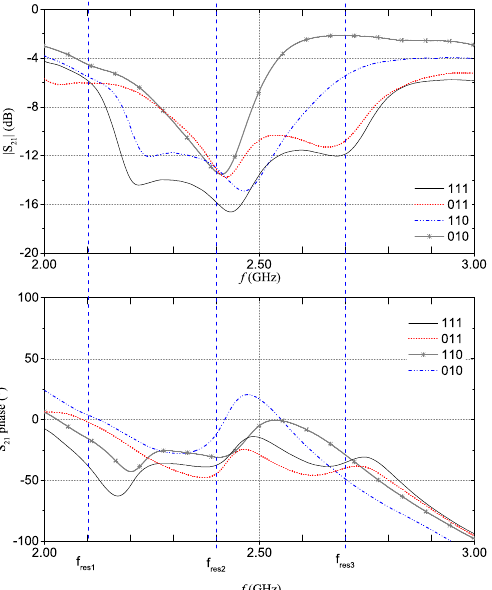
Figure 9. Measurement results for the multi-stopband structure: measurements of the magnitude ( top ) and phase ( bottom ) of the S 21 for ‘111’, ‘011’, ‘110’, and ‘010’ codes.